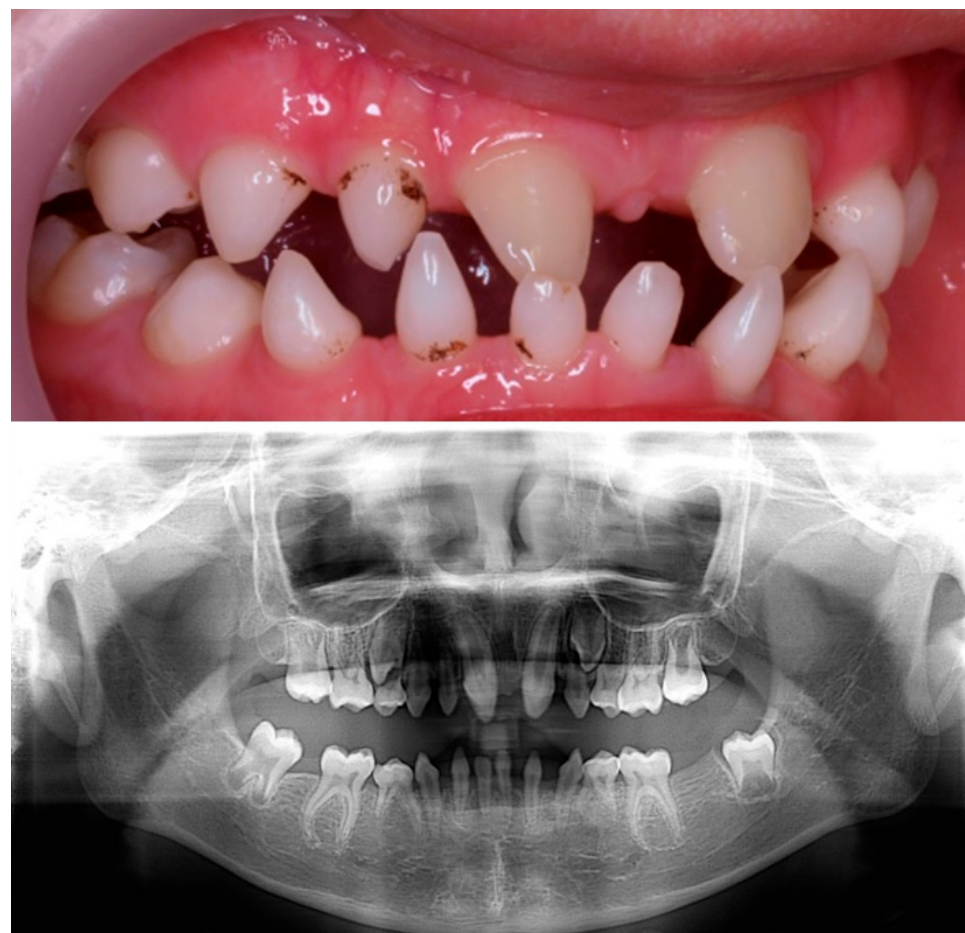
Figure 3. Clinical and radiographical findings at 11 years old.